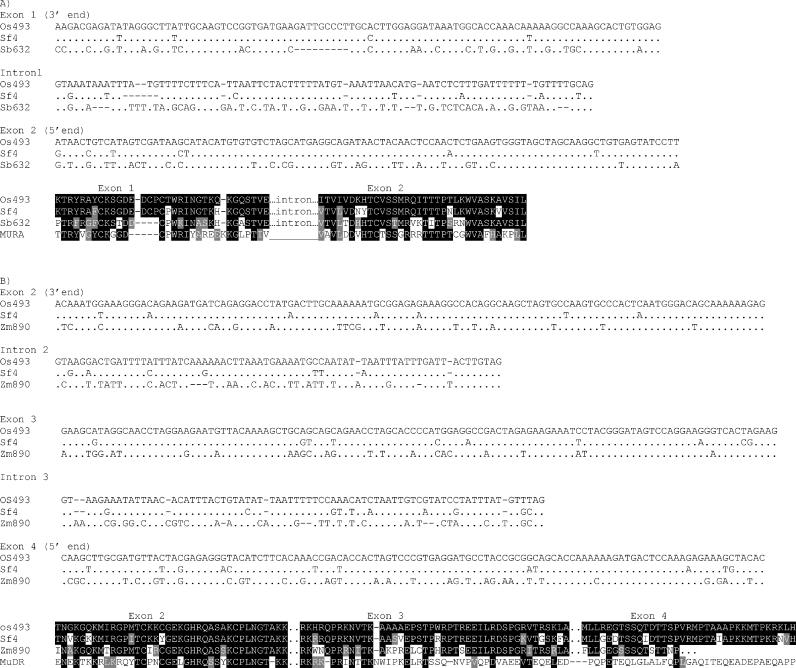
A Comparison of Coding and Noncoding Sequences from Various MULEs(A) An alignment of the nucleotide sequence of a portion of the first exon, the first intron, and a portion of the second exon from the rice, Setaria, and sorghum MULEs. Identical nucleotides are displayed as periods; differences are as indicated.(B) An alignment of the 3' end of exon 2, intron 2, exon 3, intron 3, and the 5' end of exon 4 from mudrA homologs from rice (Os493), S. faberi (Sf4), and a related element from maize (Zm890). In both panels, amino acid translations, shaded for similarity to Os493, are portrayed below the nucleotide alignments. MURA sequence is provided for comparison.